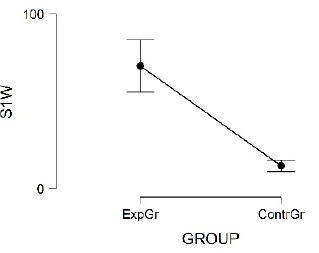
Figure 10. Descriptive plot showing significant differences between both groups regarding the number of sentences of a single word (S1W).